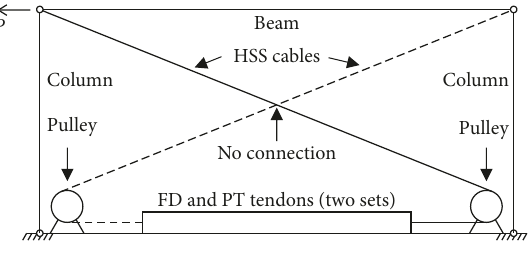
Figure 4: Arrangement of